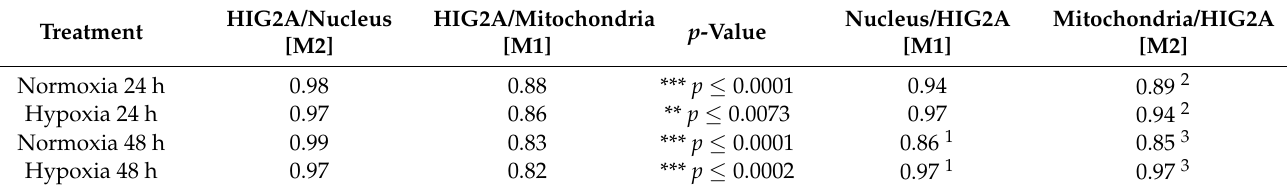
Table 2. Effect of hypoxic stress on the subcellular localization of HIG2A in